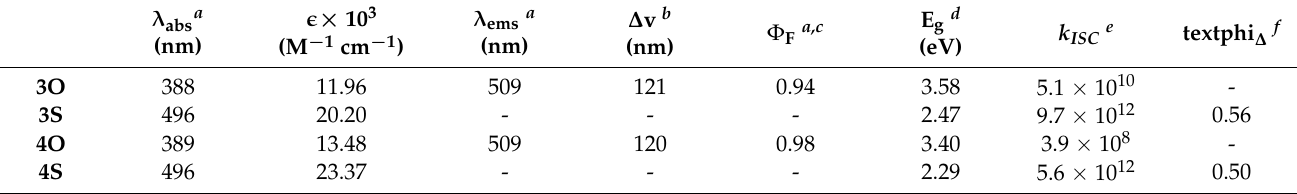
Figure 2. UV–vis absorption (black line) and PL spectra (red line) of 4O and 4S in THF (40 µ M, λ ex at maximum absorption wavelength, slit 5/5). Table 1. Photophysical and photosensitizing properties of 4O and 4S .